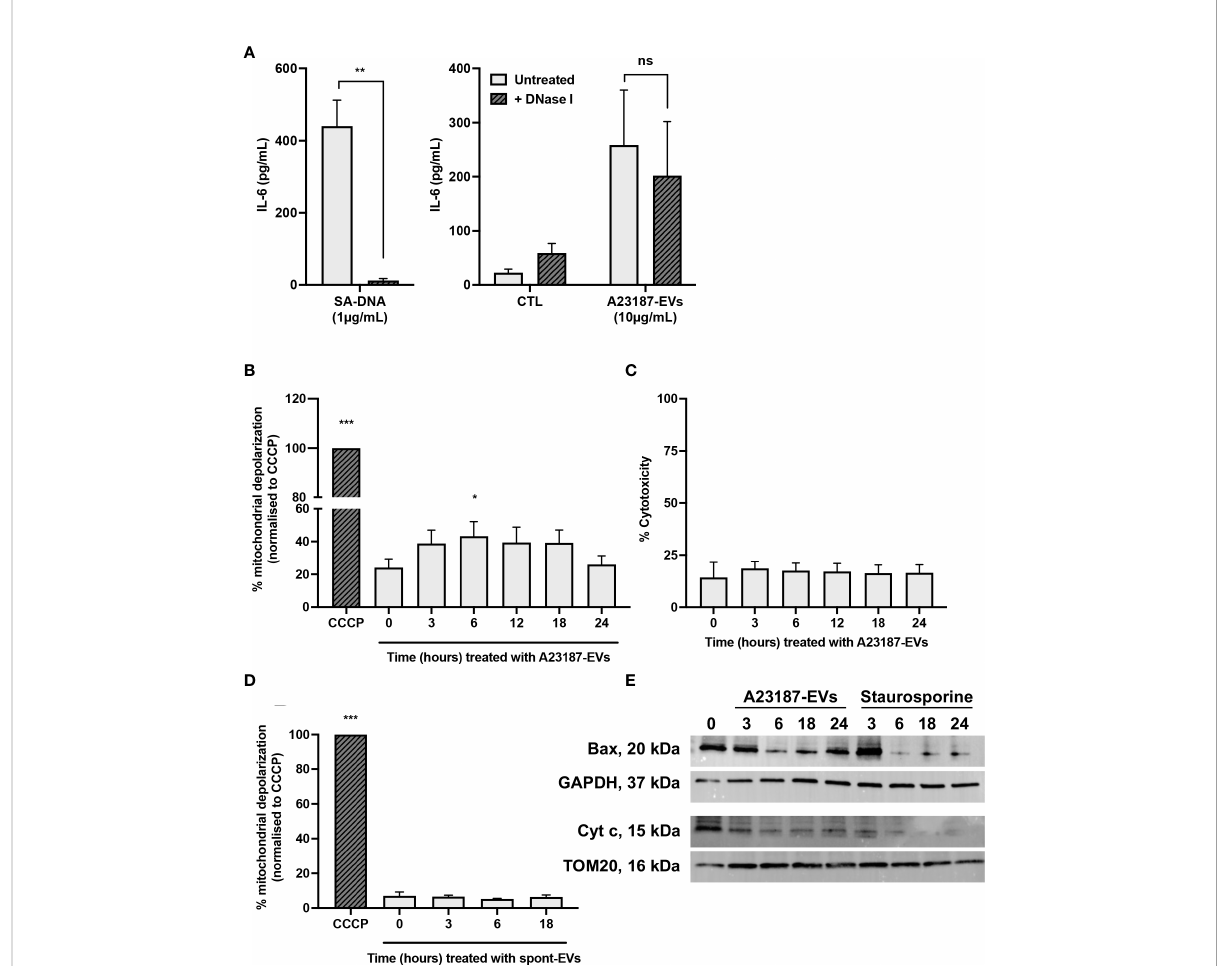
FIGURE 6 A23187-EVs cause macrophage mitochondrial dysfunction. S. aureus DNA (SA-DNA, left panel) and A23187-EVs (right panel) were treated with and without DNase I, then co-cultured with macrophages for 18 hours. Supernatants were analyzed by ELISA for IL-6 (A) . Bars represent the average of 8 experiments ± SEM. P values were determined using a paired t-test (left panel, ** p < 0.01) and a two-way ANOVA with Sidak ’ s post-test (right panel, ns, not signi fi cant,). Macrophages were left untreated, or were treated at the indicated times with A23187-EVs or CCCP, stained using JC-1, then analyzed by fl ow cytometry for loss of mitochondrial membrane polarization (B) . Data was normalized to CCCP treatment and bars represent the average of 5 experiments ± SEM. P values were determined using a one-way repeated measures ANOVA with Dunnett ’ s post-test (* p < 0.05, *** p < 0.001 vs. time 0). Following treatment of macrophages with A23187-EVs for the indicated time points, supernatants were collected and assayed LDH as a measure for cytotoxicity (C , n=3 ) . Values are expressed as fold change relative to untreated macrophages. Data are presented as the mean of 3 experiments ± SEM. Macrophages were treated at the indicated times with spontaneous- EVs or CCCP, then analyzed by fl ow cytometry as above (D) . Bars represent the average of three experiments ± SEM. P values were determined using a one-way repeated measures ANOVA with Dunnett ’ s post-test (* p < 0.05, *** p < 0.001 vs. time 0). Macrophages were treated with A23187-EVs at the indicated time points, subcellular fractionation performed, then 10 µg lysates were resolved by SDS-PAGE gel and blotted for Bax, cytochrome c, and loading controls GAPDH and TOM20, as indicated (E) . A representative result from four experiments is